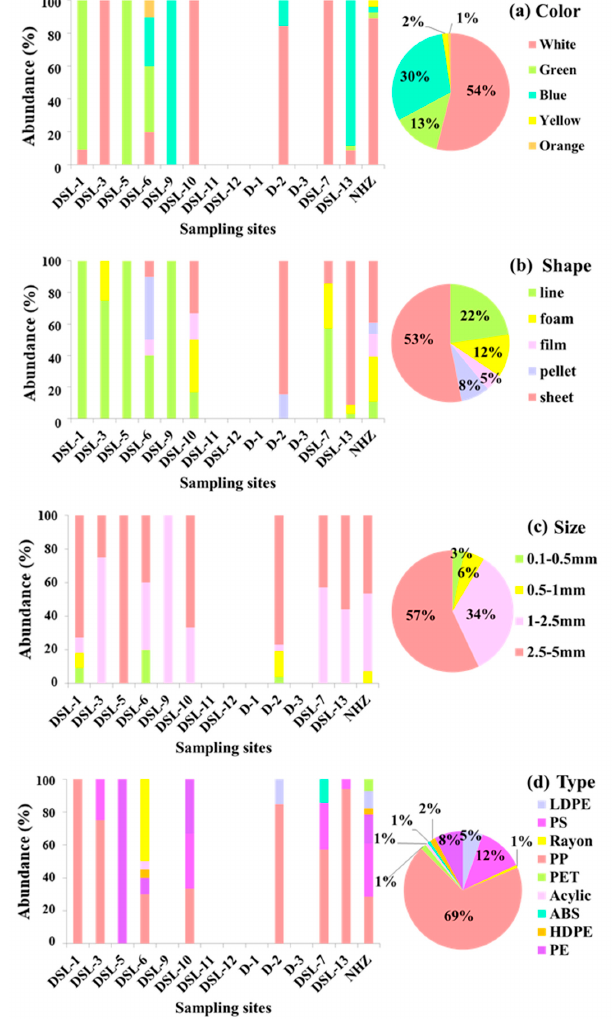
Figure 3. Color ( a ), shape ( b ), size ( c ), and polymer type ( d ) distribution of microplastics in sediment of the Dishui Lake.